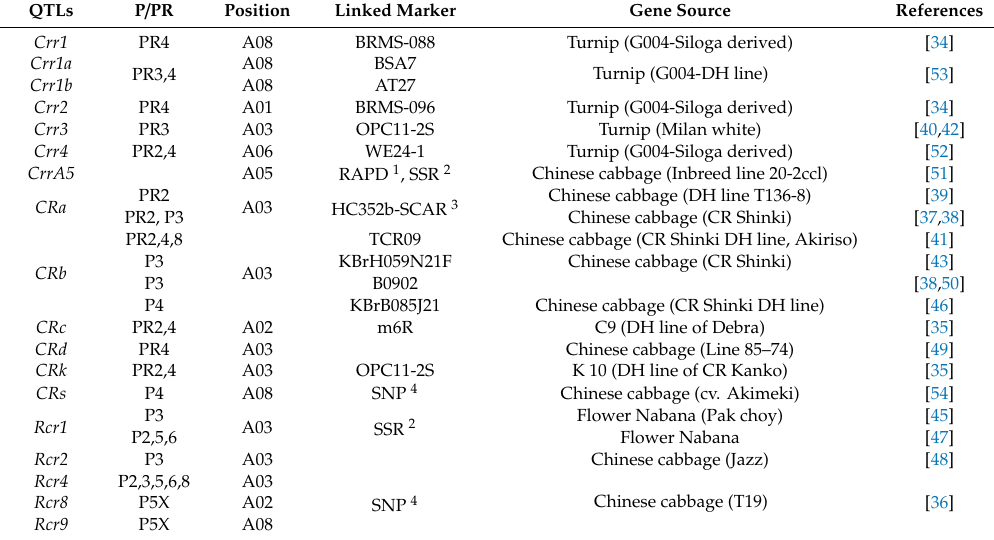
Table 1. CR loci reported on B. rapa